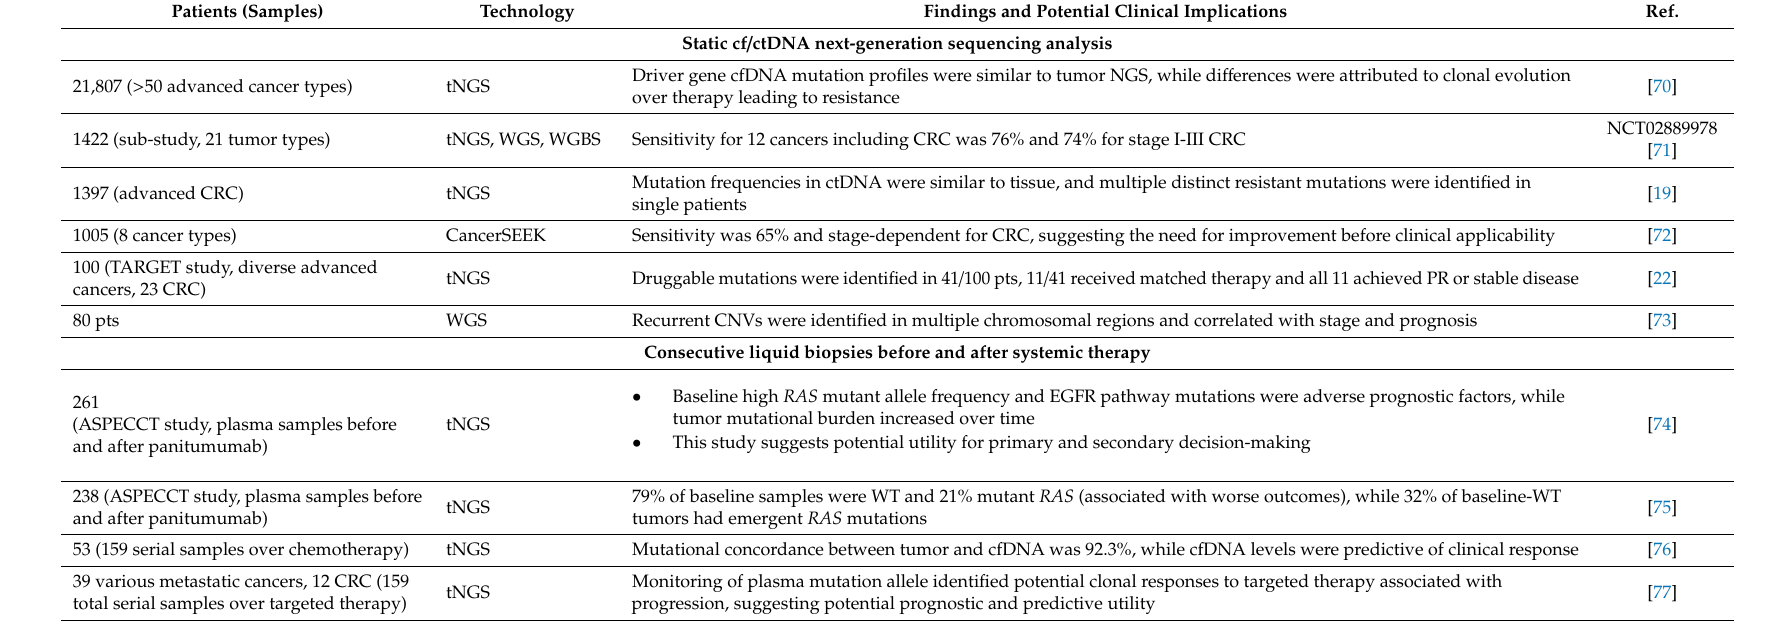
Table 3. Next-generation sequencing of circulating cell-free DNA: clinical